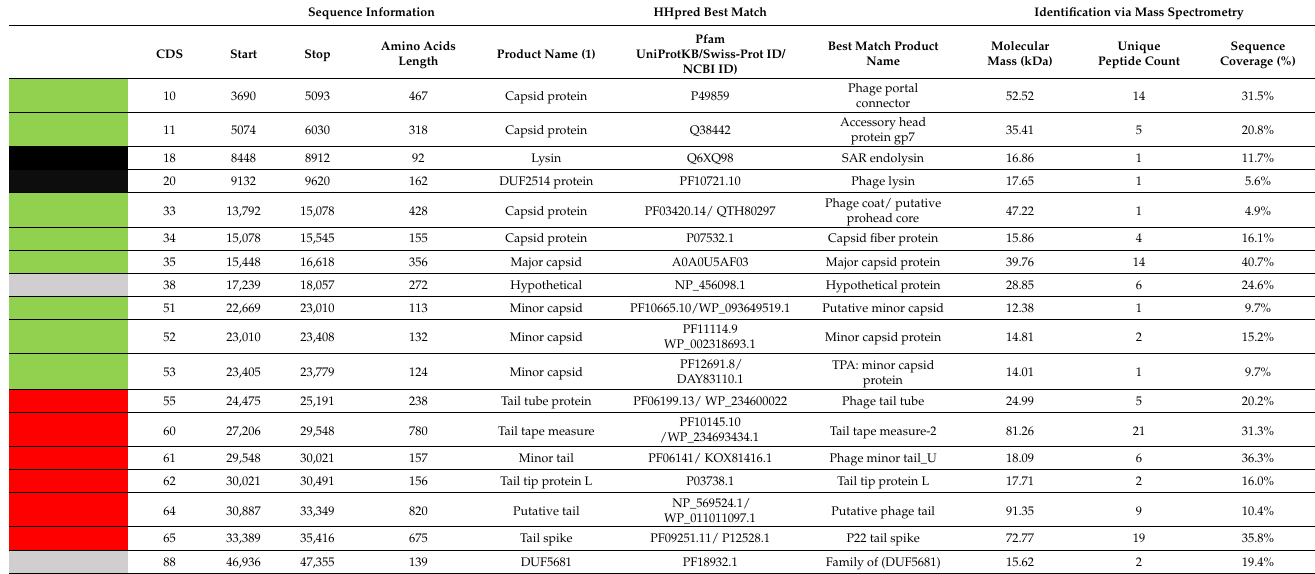
Table 1. Protein homology detection and structure prediction of